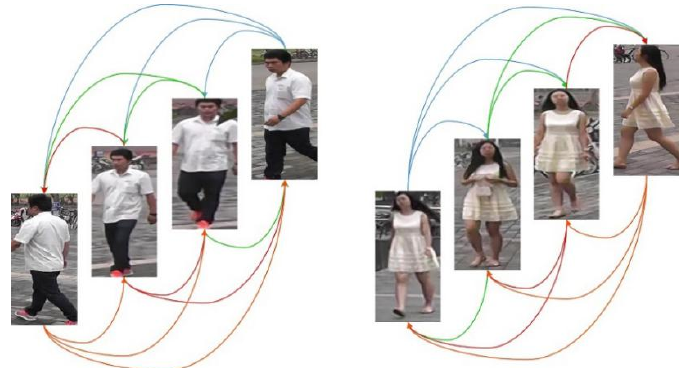
Figure 1. Some examples of the application of non-local attention in our network. The starting point of the arrow represents one frame in a video, and the picture pointed by the arrow represents another frame of the video. For brevity, we only selected four frames in the figure to show how our model directly finds relevant clues in frames to support its prediction. The ‘blue’ arrow represents the similarity between the first frame and the remaining frames, and the ‘green’, ‘red’, and ‘orange’ respectively represent the similarity of the second, third, and fourth frames with the remaining frames.